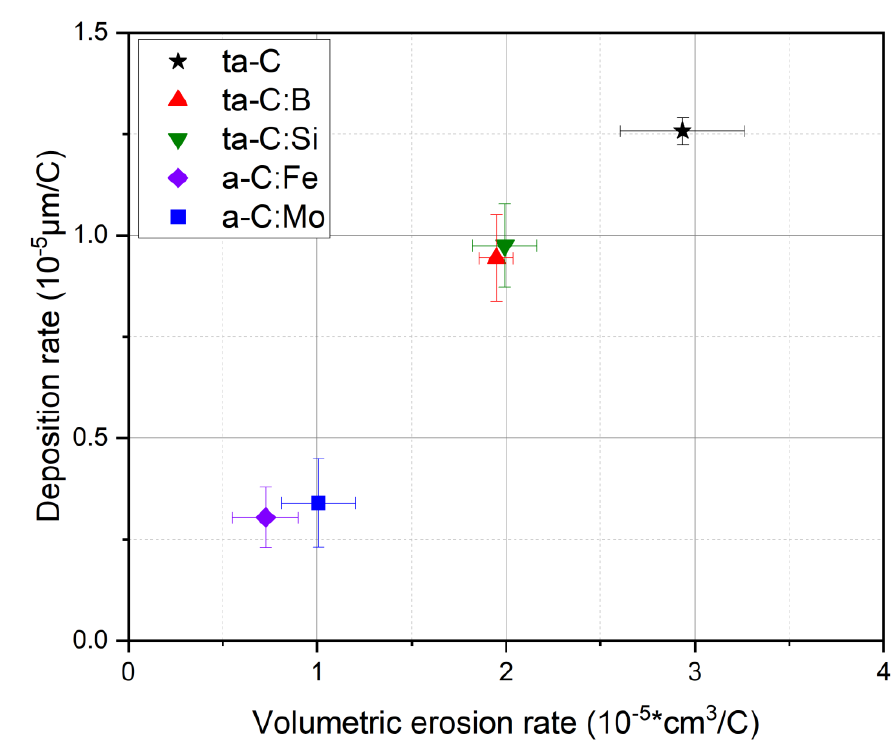
Figure 9. Deposition rate D r over the volumetric erosion rate E r,v of coatings for sample position P1; mounted along the plane of the cathode